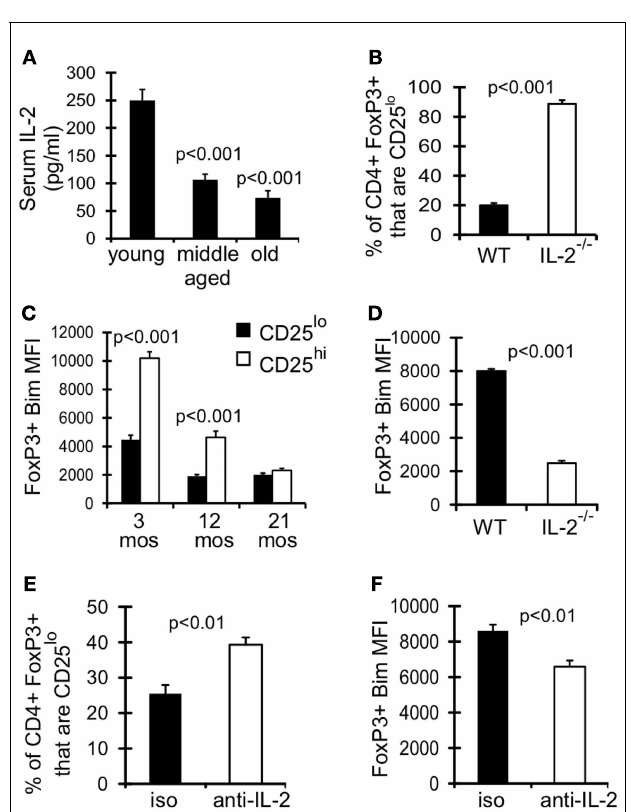
FIGURE 5 | Declining IL-2 levels drives emergence of CD25 lo Bim lo T reg . (A) Serum IL-2 was determined by IVCCA. Results show the average serum IL-2 levels from young (3–4months; n = 10), middle-aged (11–12months; n = 11), and old ( > 15months; n = 9) mice ( ± SE). Results are representative of 3 independent experiments.The p values represent the difference compared to young (Student’s t test). (B,D) Splenocytes from 5-week-old C57BL/6 wild-type (WT; n = 4) and IL-2 − / − ( n = 3) mice were stained for CD4, FoxP3, CD25, and Bim and analyzed by flow. (B) Results show the frequency of CD4 + FoxP3 + cells that are CD25lo ( ± SE) and are representative of two independent experiments. (C) Splenocytes from 3month ( n = 4), 12month ( n = 4), and 21-month-old ( n = 5) mice were stained for CD4, FoxP3, CD25, and Bim and analyzed by flow. Results show the Bim MFI of CD4 + FoxP3 + CD25 lo cells and CD4 + FoxP3 + CD25 hi cells ( ± SE).The p values represent the difference between CD25 lo and CD25 hi T reg (Student’s t test). (D) Results show the Bim MFI of CD4 + FoxP3 + T reg fromWT and IL-2 − / − mice ( ± SE) and are representative of two independent experiments. (E,F) Three-month-old mice were injected with IL-2 neutralizing antibodies or IgG isotype control ( n = 4/group). Spleens were harvested at day 7 and stained for CD4, FoxP3, CD25, and Bim. (E) Results show the frequency of CD4 + FoxP3 + cells that are CD25 lo ( ± SE). (F) Results show the Bim MFI of CD4 + FoxP3 + T reg ( ±